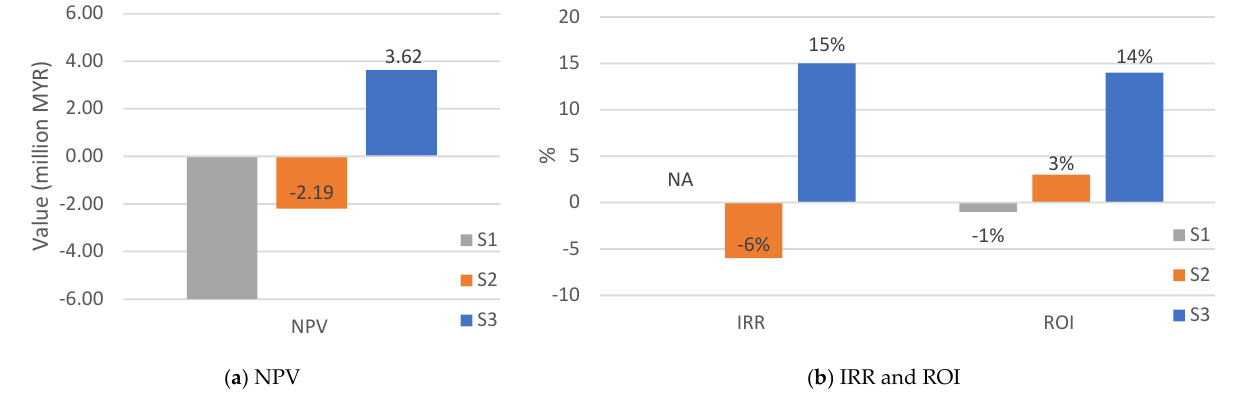
Figure 4. NPV, IRR and ROI for S1, S2 and S3.